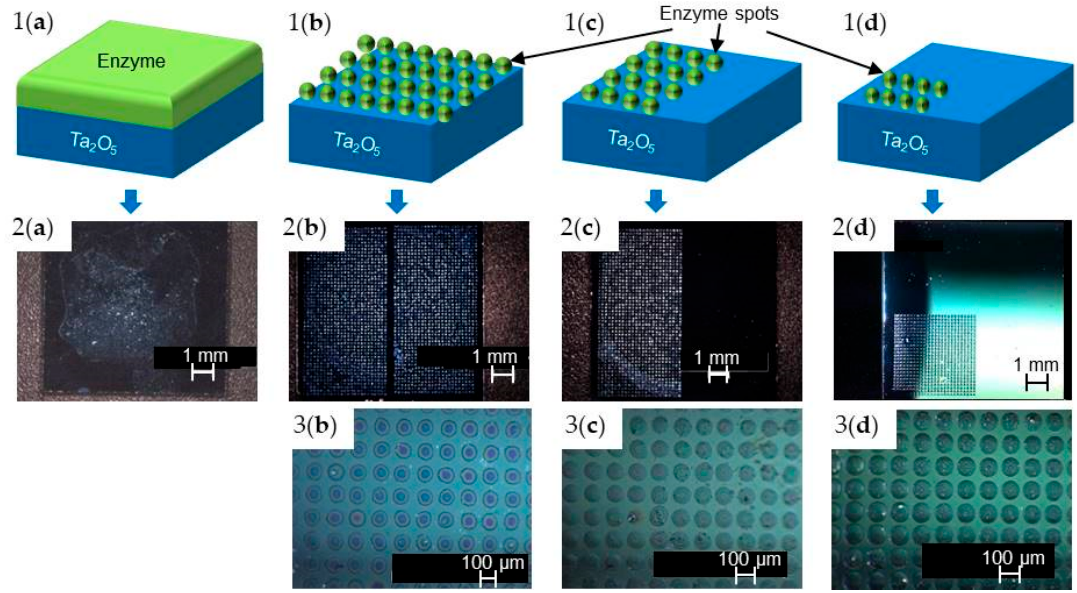
Figure 2. Schematic of EIS sensor modified with enzyme by means of drop-coating (sensor type 1 a ), fully spotted (sensor type 1 b ), half spotted (sensor type 1 c ) and quarterly spotted (sensor type 1 d ). Corresponding digital video microscopy images with an optical magnification of 25x (2 a –2 b ) and 100x (3 b –3 d ), respectively.